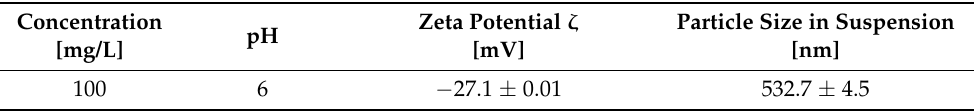
Table 2. Physicochemical Properties of HA solution (determined by Zetasizer Nano ZS90, Nanoparti- cle Size Analyzer, Tokyo,